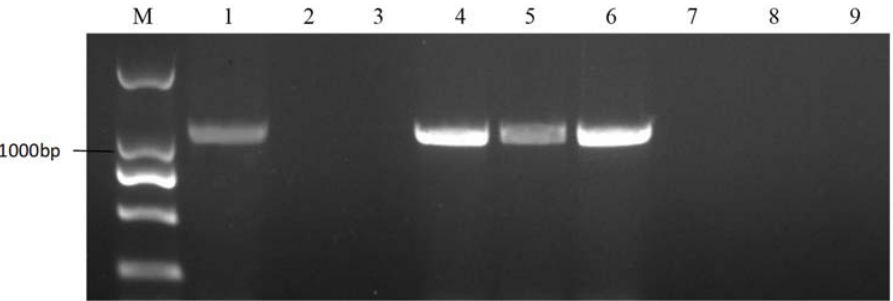
Figure 5. PCR amplification of KD4/KD7 in 18-512 sister lines. M represents the DNA Marker 2000; 1 represents the positive control; and 2 represents the negative control l. Lanes 3–9 are 18-512, 18-2169-1, 18-2169-2, 18-2169-3, 18-2170-1, 18-2170-2, and 18-2170-3.